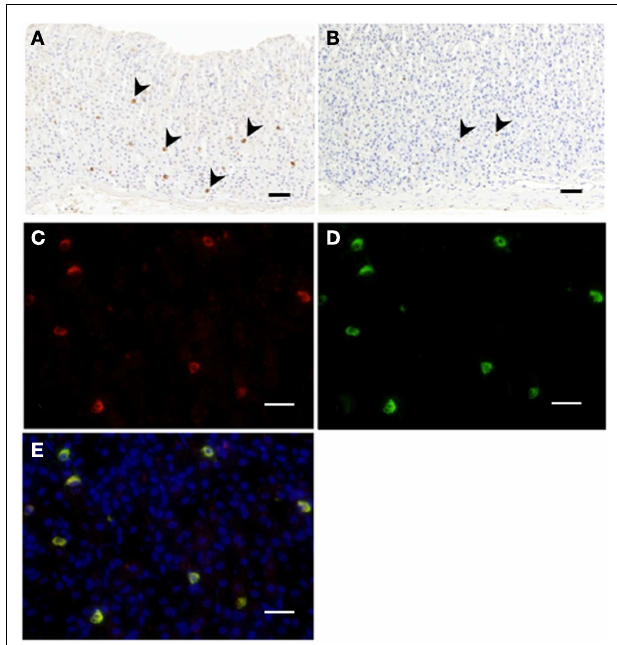
FIGURE 1 | Immunohistochemistry for C8-ghrelin (A) or C10-ghrelin (B) in fundi of stomachs in control mice .The density of DAB staining in cells reflecting C10-ghrelin-immunoreactivity (ir-C10-ghrelin) was lower than that of ir-C8-ghrelin (A,B) . Immunofluorescence in fundi of stomachs in control mice (C–E) . Ir-C8-ghrelin (C) labeled with Alexa 555 (red), and ir-C10-ghrelin (D) labeled with Alexa 488 (green) are observed in the same section.The yellow color in the merged image (E) indicated a co-localization of ir-C8- and ir-C10-ghrelin. Arrowheads indicate ghrelin-positive cells (A,B) . Scale bars represent 100 µ m (A,B) and represent 25 µ m (C–E) .